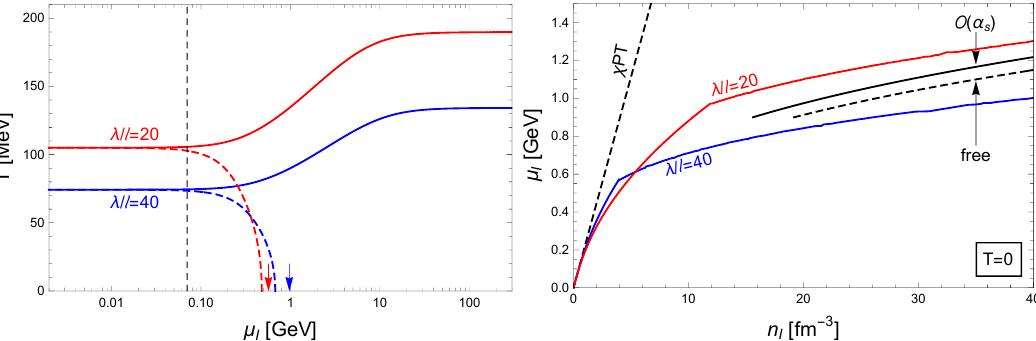
Figure 8: Left panel: Phase transition (solid) between the pion-condensed phase without baryons and the chirally symmetric phase in the plane of temperature T and isospin chemical = 0 and two different values of λ/(cid:96) . The arrows indicate the zero- potential µ for µ I B temperature onset of baryons (in the presence of a pion condensate). The dashed curves show the corresponding chiral phase transition in the absence of pion condensation. The vertical thin dashed line marks the zero-temperature critical chemical potential for pion condensation = m / 2. Right panel: Isospin chemical if a physical pion mass was taken into account, µ π I = T = 0 and the same values of λ/(cid:96) potential as a function of the isospin density n for µ I B as in the left panel. The cusp in the curves corresponds to the baryon onset. The curves are compared to the ones from chiral perturbation theory ( χ PT), free quarks, and perturbative QCD to order α s